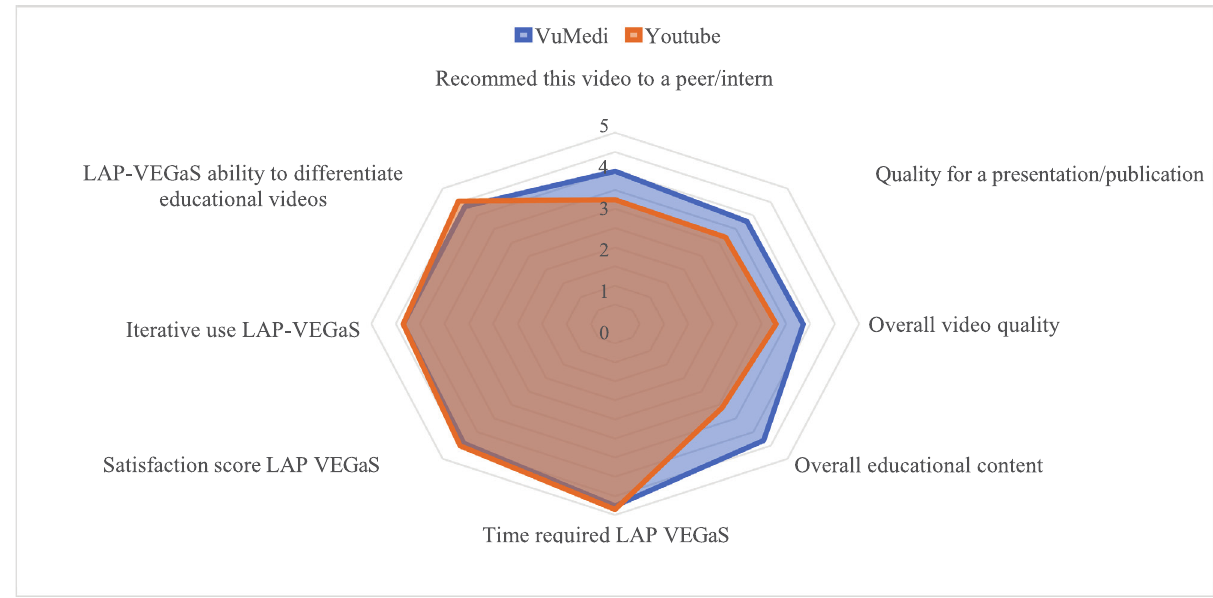
Figure 5. Comparative diagram of the 5-point Likert